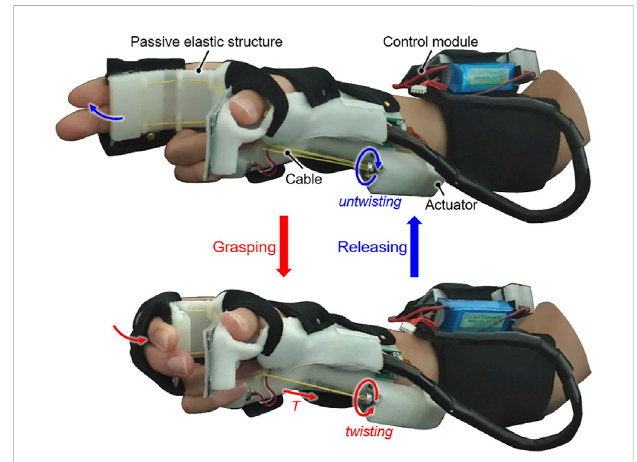
FIGURE 1 The active hand orthosis made by the spatial stiffness distribution design for assisting with grasping tasks during activities of daily living (ADL). The entire orthosis, including the single actuator, was designed to fi t compactly on the hand and